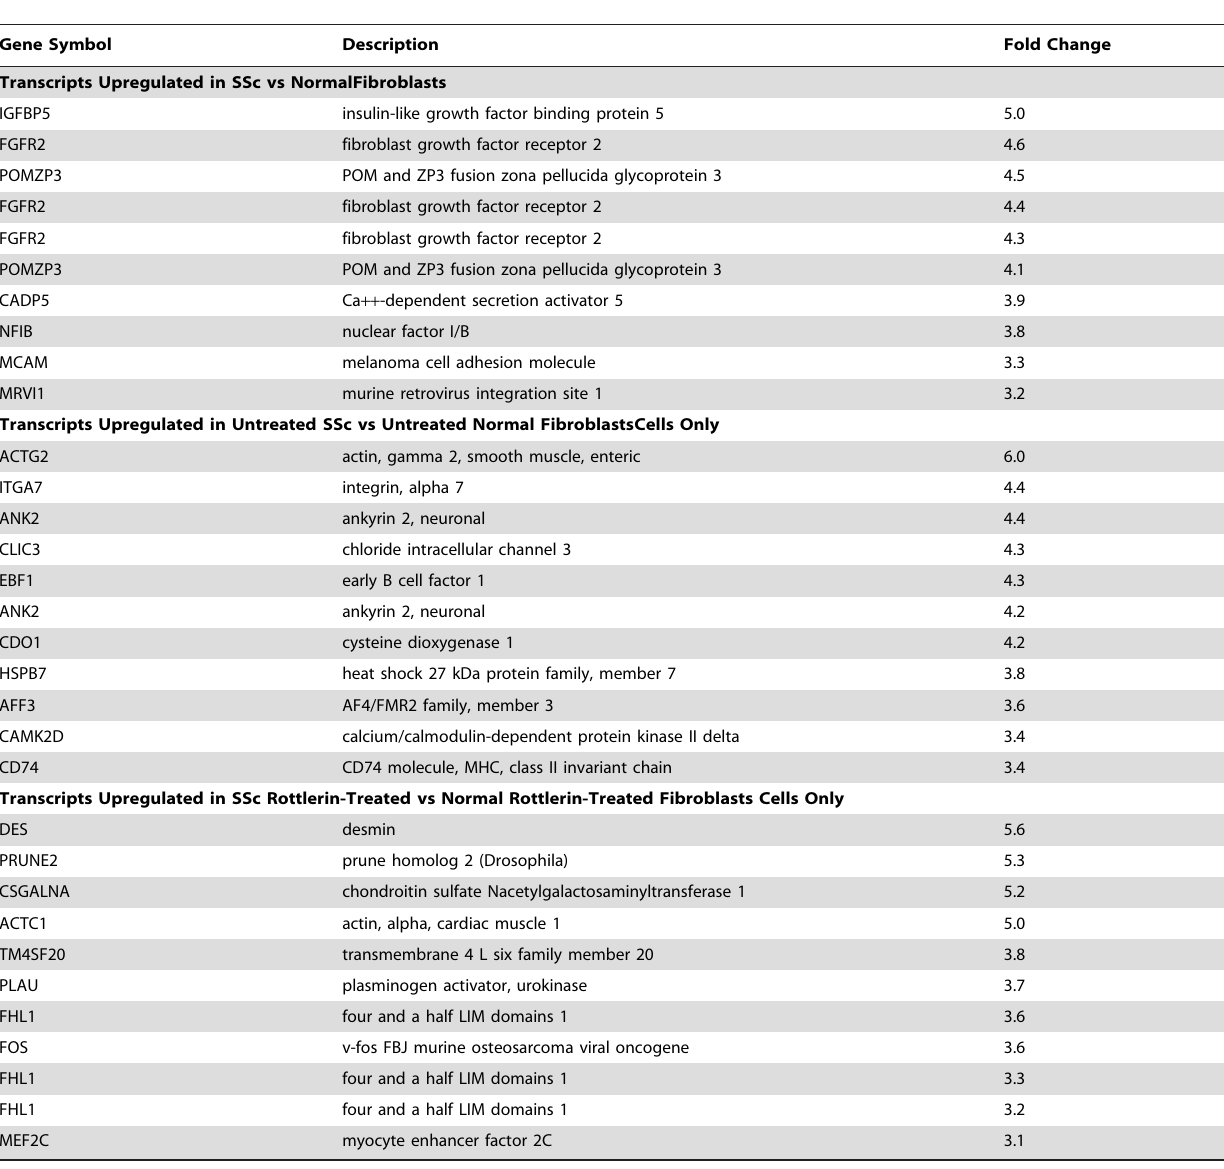
Table 6. Selected transcripts upregulated in SSc fibroblasts.